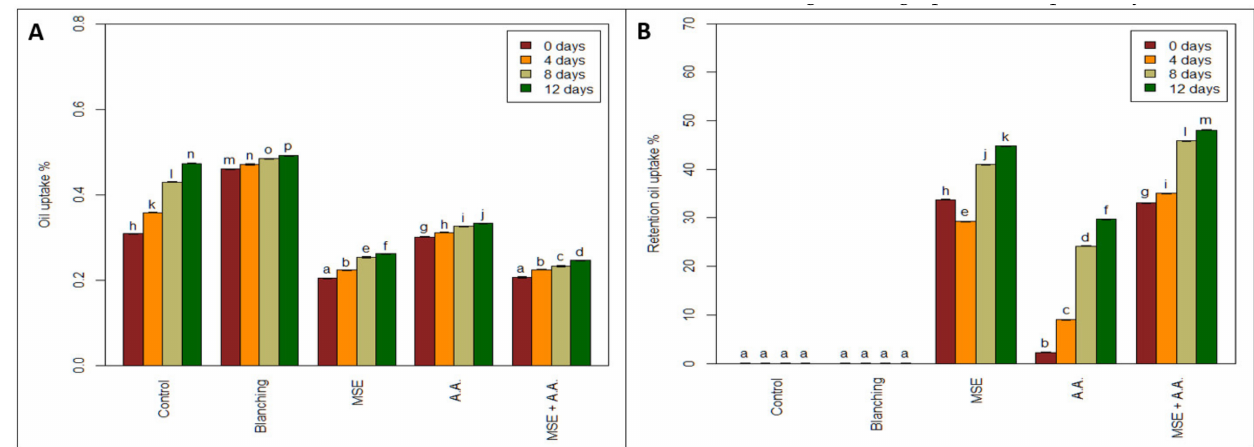
Figure 4. Effect of ascorbic acid (AA), mucilage seed extract (MSE), MSE + A.A, and blanching on oil uptake ( A ) and retention oil uptake (%) ( B ) of fresh-cut potato strips. (Means with the same CLD letter are not statistically significantly different. Letters come from holm-corrected multiple comparisons across all times and